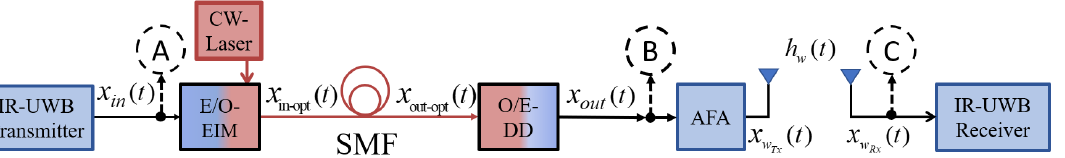
Figure 2. Proposed optical-wireless spectral line-free (SLF) IR-UWBoF system; E/O-IM: Electrical to Optical Intensity Modulation; SMF: Single Mode Fiber; O/E-DD: Optical to Electrical Direct Detec- tion; AFA: Amplification, Filtering, Amplification.